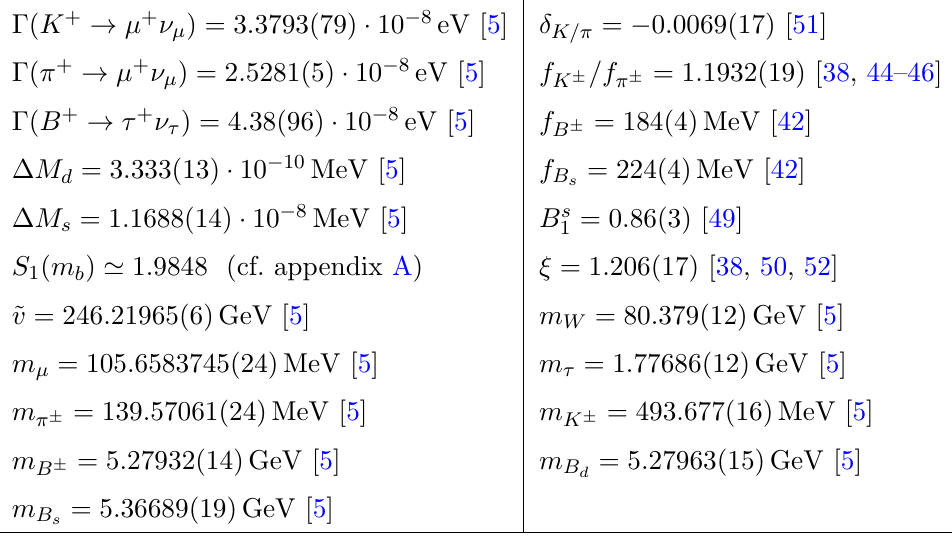
Table 2 . Set of inputs used in the numerical